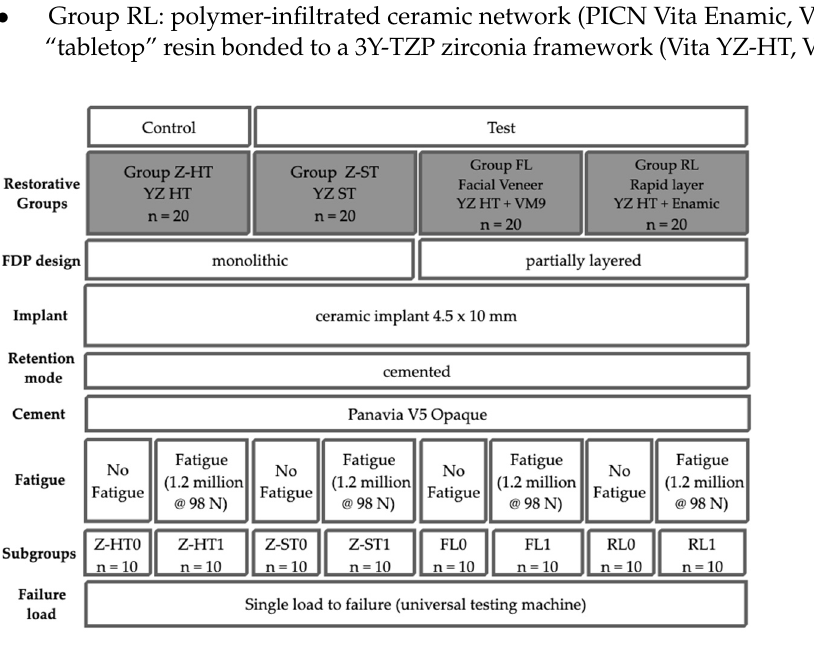
Figure 1. Study set-up. Table 1. Prosthetic materials with group names and studied implant with characteristic flexural strength according to manufacturer’s information.